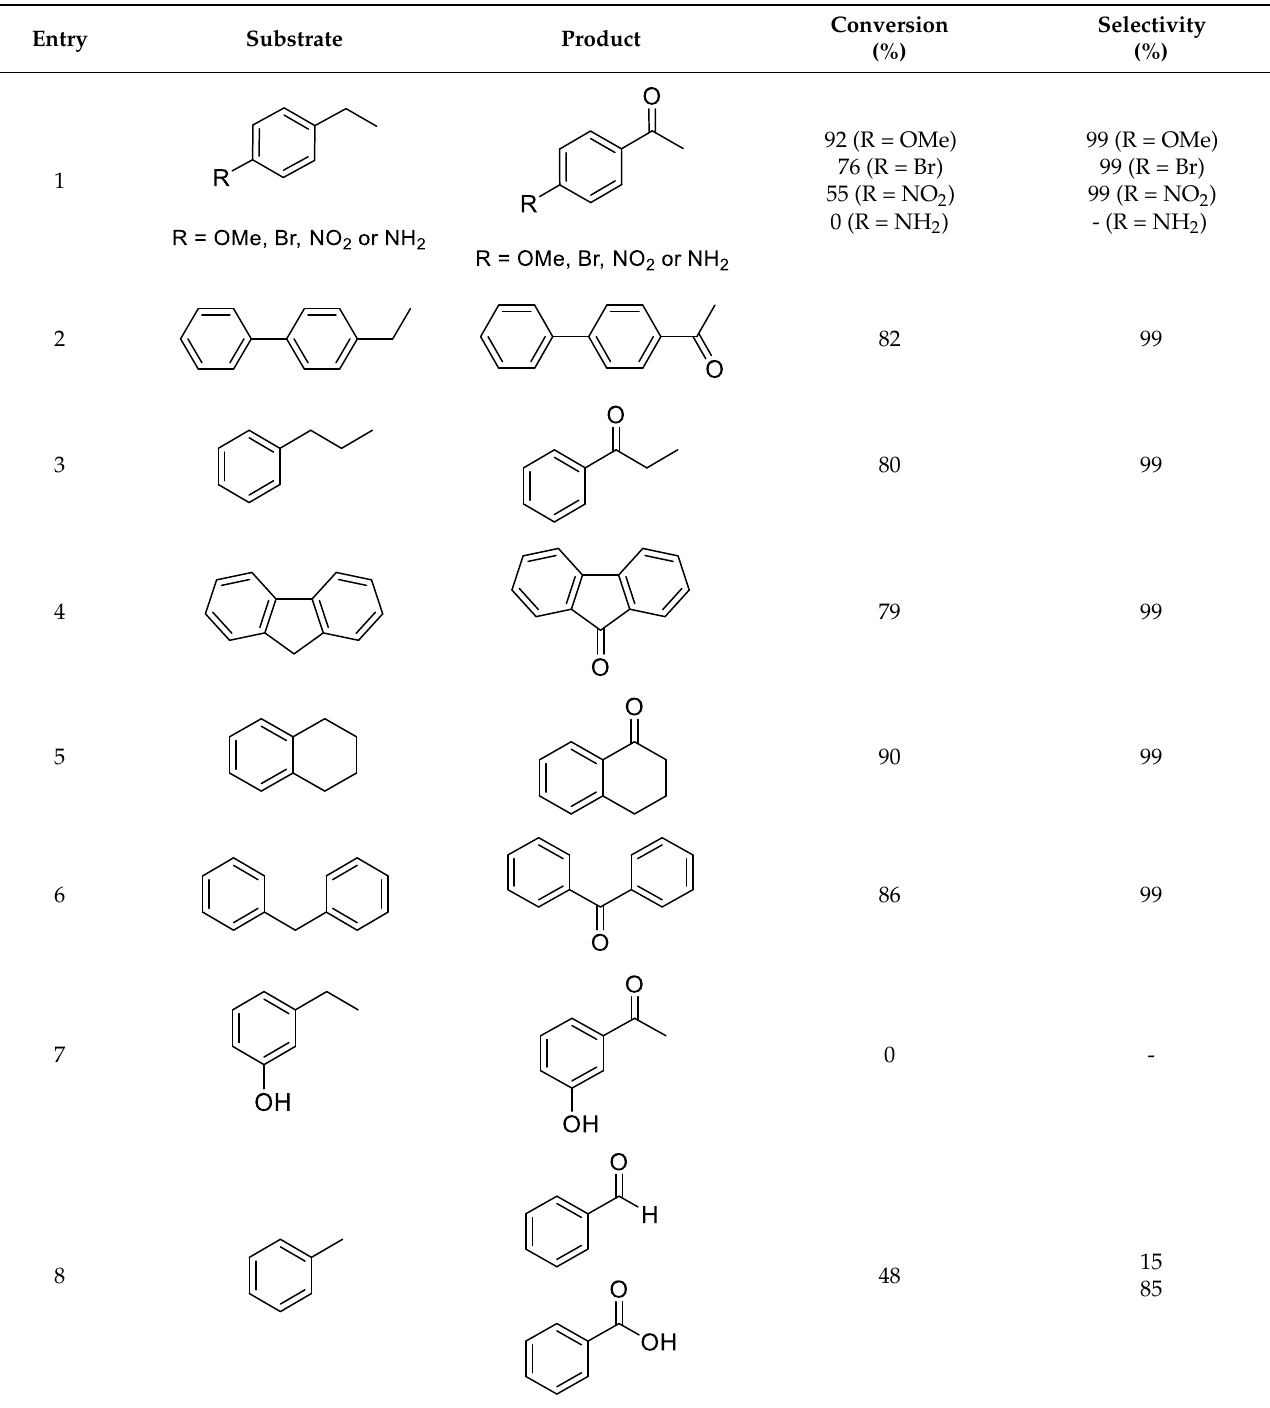
Table 4. Catalytic oxidation of different substrates using Co(II)Pc(SO 3− ) 4 @-Zn 2 Al-LDH as catalyst [79] *.